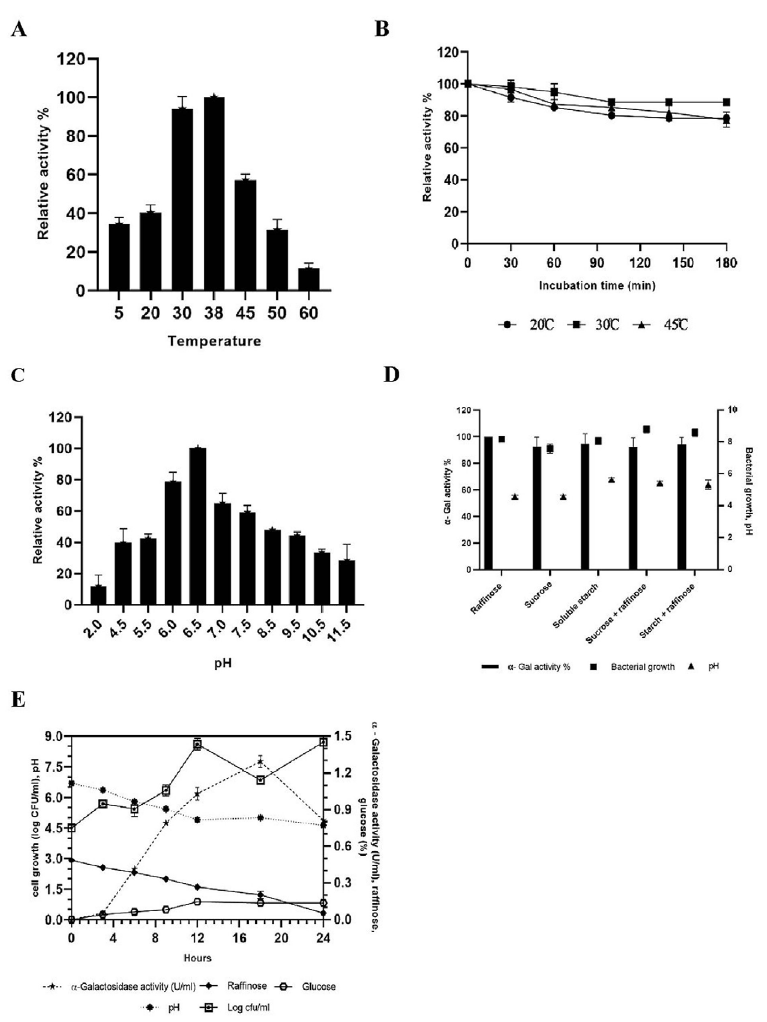
Fig. 4. Effect of temperature (A), temperature stability (B), pH (C); effect of different carbon source in growth medium (D) on the production of a-galactosidase activity and kinectics of a-galactosidase, bacterial growth and hydrolysis of raffinose (E) during fermentation with L. brevis in mMRS